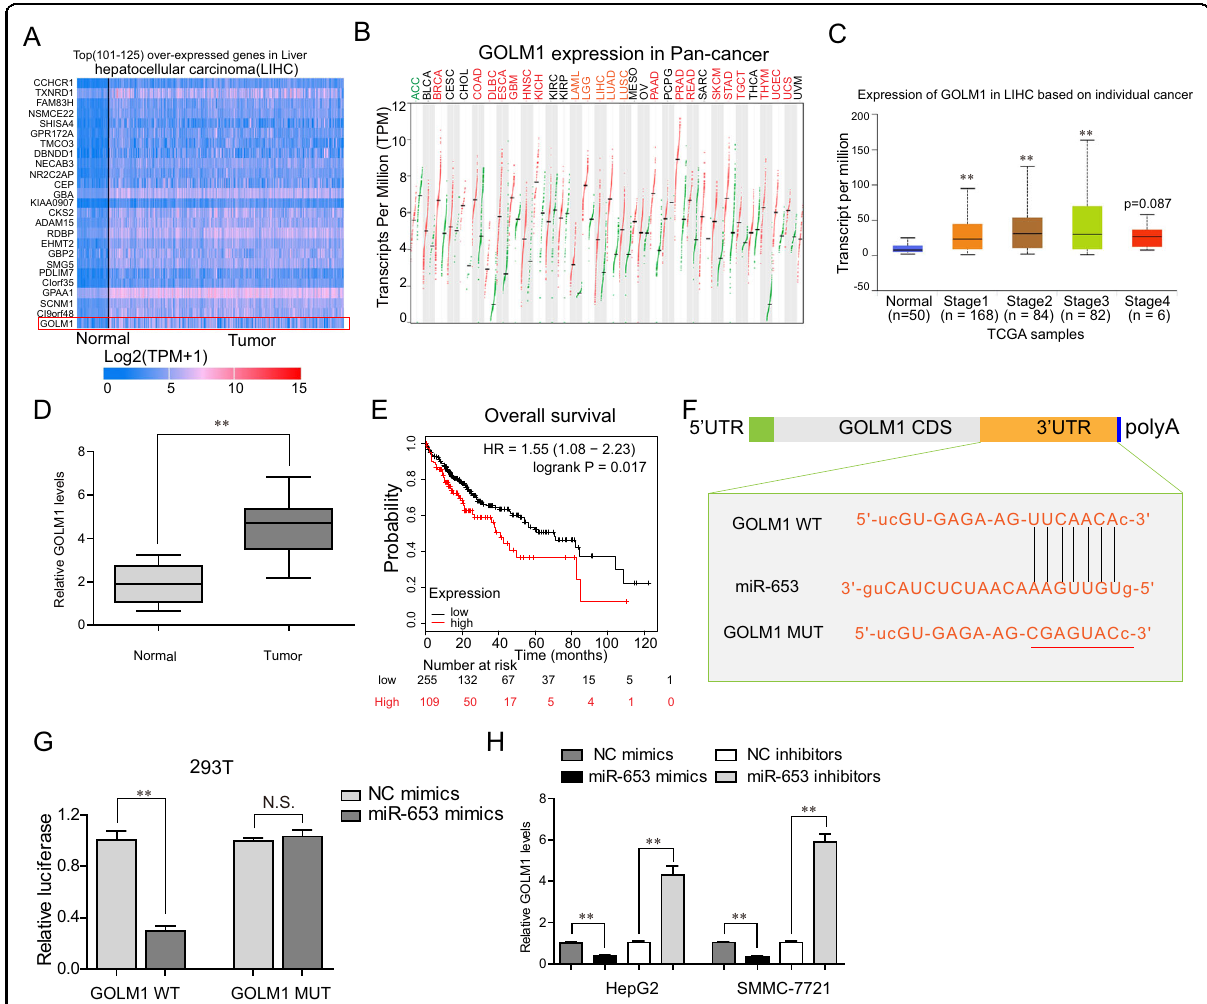
Fig. 7 GOLM1 was a direct target of miR-653 in HCC cells. A UALCAN algorithm analyzed partial highly expressed lncRNAs in HCC tumor samples. GOLM1 heatmap was labeled with a red frame. B GEPIA algorithm analyzed GOLM1 expression across diverse cancer types. C UALCAN algorithm analyzed GOLM1 expression in HCC tumor specimens of patients from stage I to stage III. D Real-time PCR detected GOLM1 levels in 127 HCC samples. E Kaplan – Meier Plotter algorithm analyzed the overall survival of HCC patients with high or low GOLM1 expression. F Predicted binding site between miR-653 and 3 ’ UTR of GOLM1 mRNA using strabase algorithm. G Luciferase reporter assays. H GOLM1 levels in HCC cells were assessed by qPCR analyses when their miR-653 was overexpressed or knocked down. Data are presented as the mean ± SD from three independent experiments. * P < 0.05, ** P <